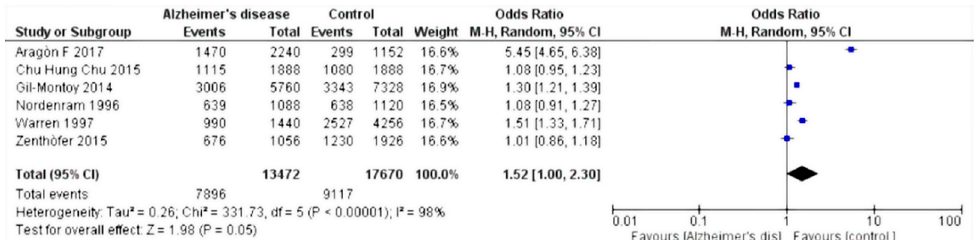
Figure 1. Flowchart describing research methodology, following the PRISMA protocol guidelines.